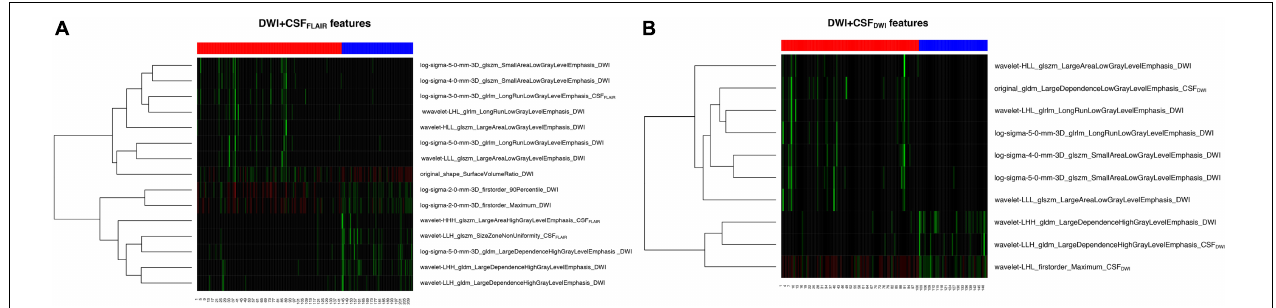
FIGURE 3 | Heatmaps of the selected 15 features (A) and 10 features (B) .